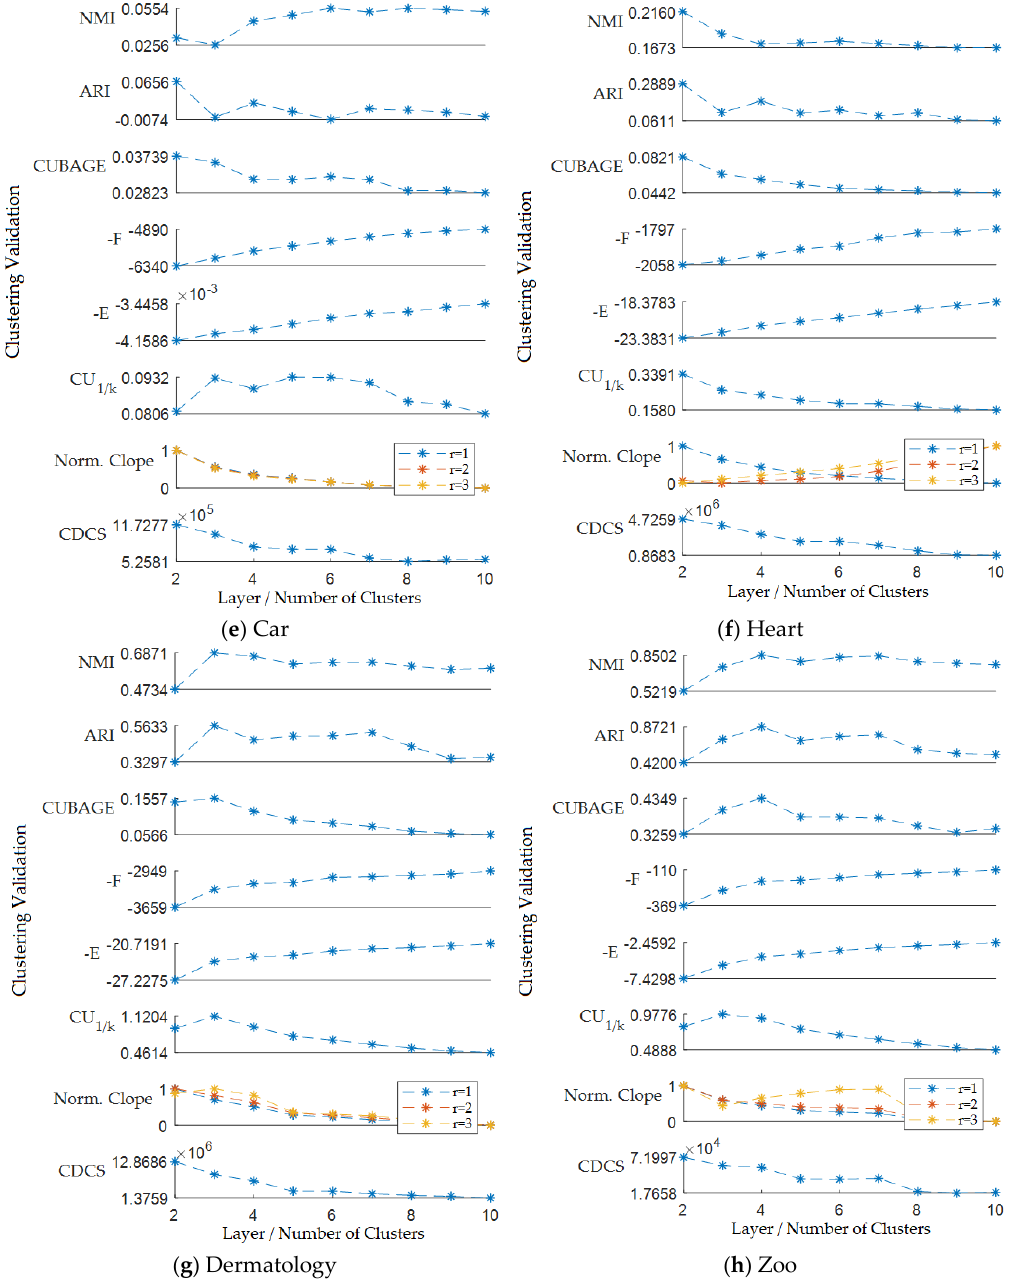
Figure 6. The validation scores of each layer of the hierarchy on different datasets. On axis OX are the layers, i.e., partitions of different size; on axis OY are the values of the validation (quality) of each partition measured by different CVIs. Note that the values of Clope r ( P ) with the parameter r = 1~3 have been normalized for convenience of comparison.